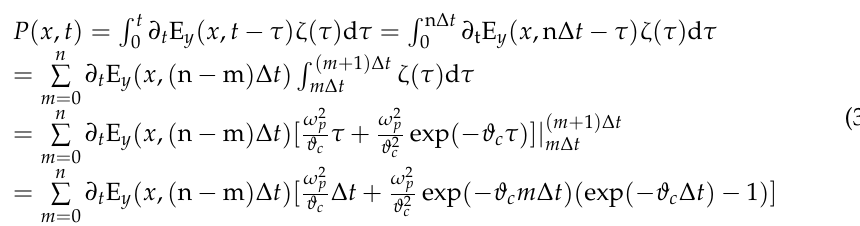
Table 1. Conversion between LBM and physical space. Denomination LBM Context Physical Context Space step